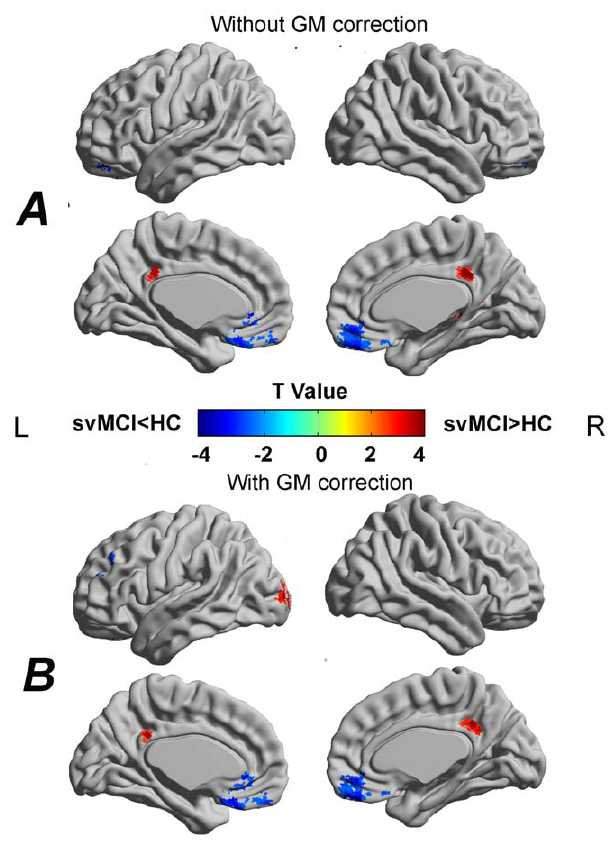
Figure 4. Between-group differences in the amplitude of LFO without (A) and with (B) correcting GM volume. The svMCI patients showed decreased LFO amplitudes in frontal and temporal regions whereas increased LFO amplitudes in parietal and occipital regions. For the details, see Table 3. Of note, the between-group differences in the LFO amplitudes exhibited highly similar patterns between with and without correcting GM volume. The statistical threshold was set at P , 0.01 for individual voxels and cluster size . 972 mm 3 , which corresponded to a corrected P , 0.01 determined by Monte Carlo simulations. The t statistical maps were rendered by using the BrainNet Viewer (http://www.nitrc.org/projects/bnv/).R, right; L, left.